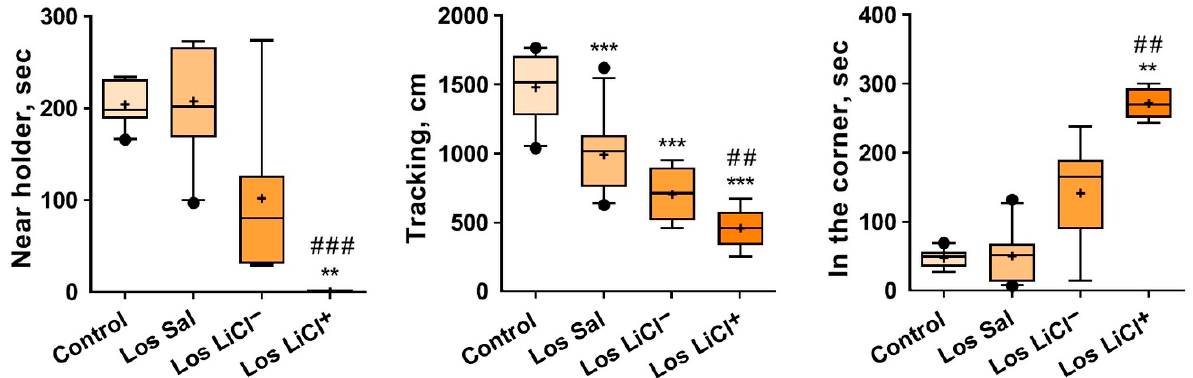
Figure 4. Effects of LiCl on the exploratory behavior of defeated mice in the novel environment and towards the novel object (pencil holder). Note: Control ( n = 9); Los Sal-Sal-treated losers ( n = 11); Los LiCl-LiCl-treated losers ( n = 7); Los LiCl + - LiCl + -treated losers ( n = 5). The values are means (plus sign), medians (solid lines), and 25%/75% quartiles in the box-whisker plot, with whiskers indicating the 10th and 90th percentiles. ** p < 0.01, *** p < 0.01 vs. controls; ## p < 0.01, and ### p < 0.001 vs . Sal-treated losers (Tukey’s multiple-comparison post hoc test).